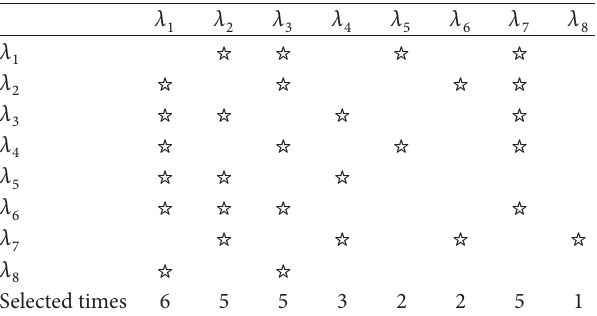
Figure 3: The ISCs of the vibration signals with the bearings fault with bearing fault in fault diameter of 0.021inches. Table 3: Feature selection results based on